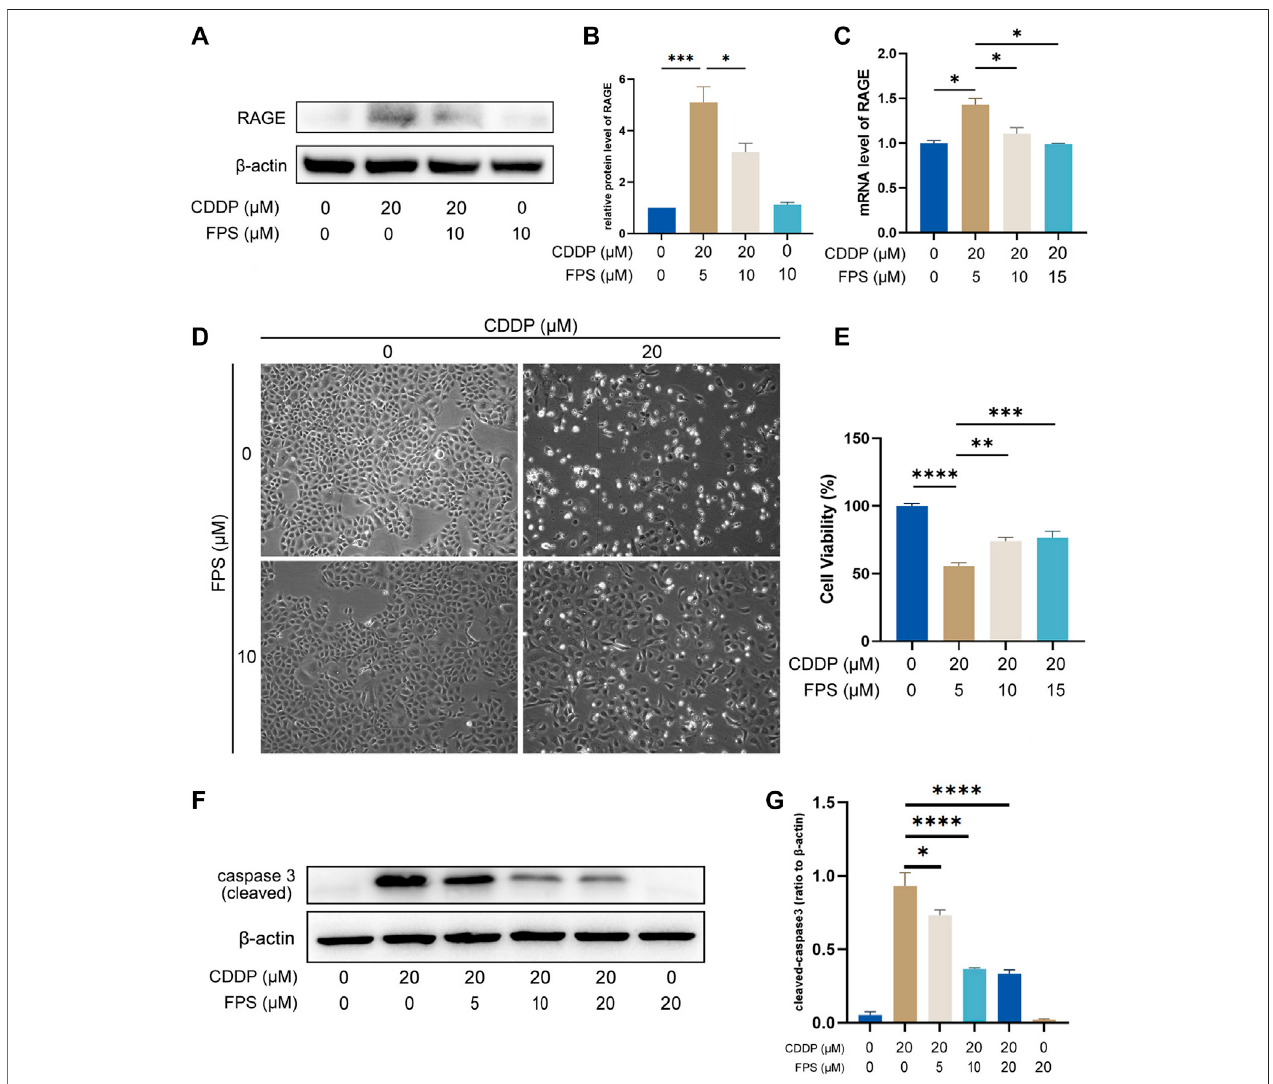
FIGURE6| The RAGE-speci fi cinhibitor FPS-ZM1 restored cisplatin-suppressedNRK-52Ecell viability.The protein levelofRAGE inNRK-52Ecellswasaccessed by western blot (A) and semi-quanti fi ed (B) . (C) The mRNA level of RAGE in NRK-52E cells determined by qPCR. (D) The viability status of NRK-52E cells observed under a microscope. (E) Quanti fi cation of cell viability by CCK-8. The protein level of RAGE cleaved caspase 3 (F) was assessed by western blot, followed by semi- quanti fi cation (G) .One-wayANOVAwasusedtocomparemeansbetweengroups.Dataareexpressedasmean±SEM.* p < 0.05,** p < 0.01,*** p < 0.001,**** p < 0.0001; FPS,